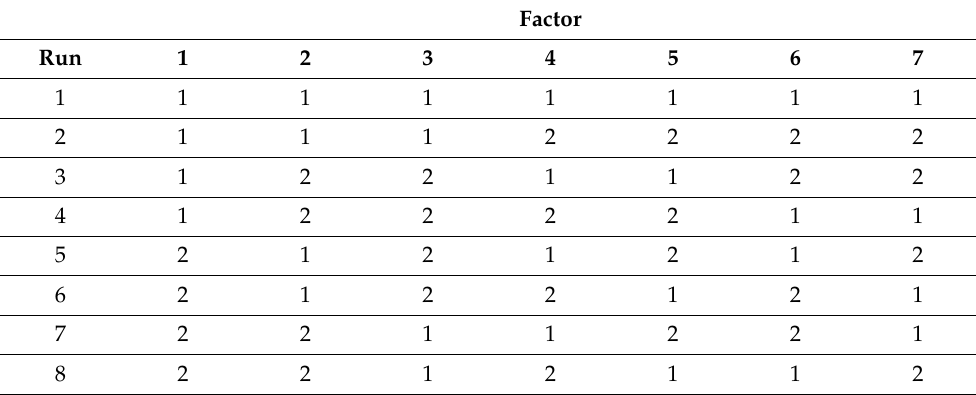
Table 1. An example of an Orthogonal Array (OA) structure of type L8 2 7 array.